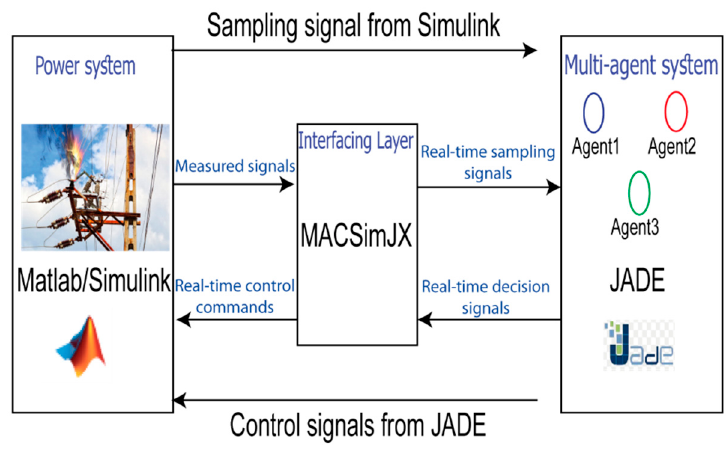
Figure 3. MATLAB/Simulink and JADE